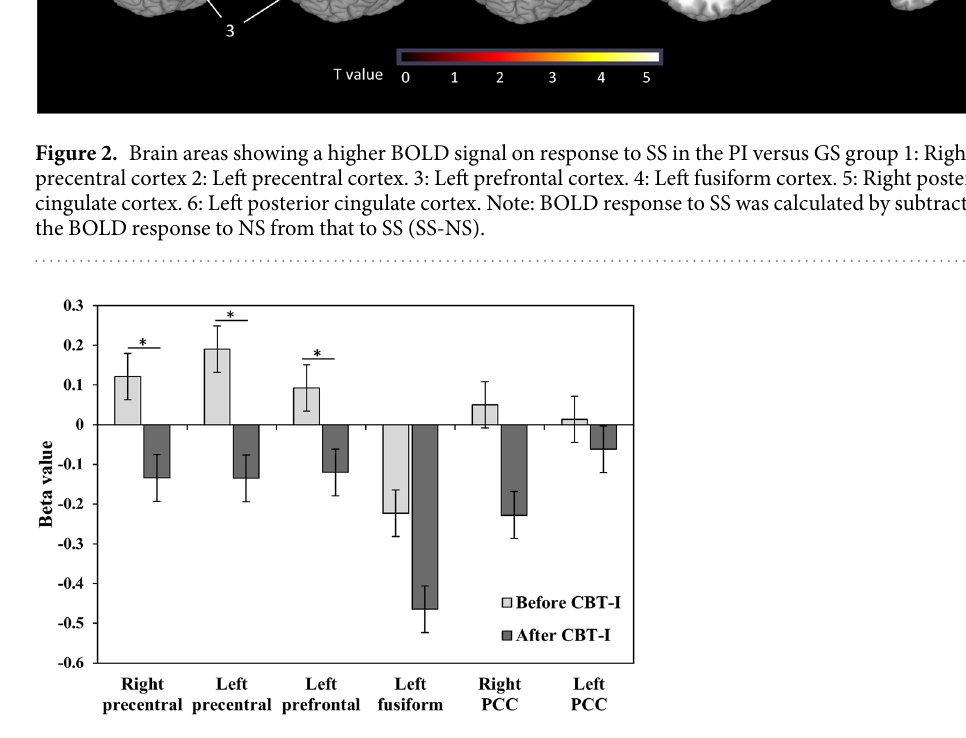
Figure 3. Regions of interest having higher BOLD signals in response to SS in PI, and changes in BOLD after CBT-I. Note: BOLD response to SS was calculated by subtraction of the BOLD response to NS from that to SS (SS-NS). Mean ± standard